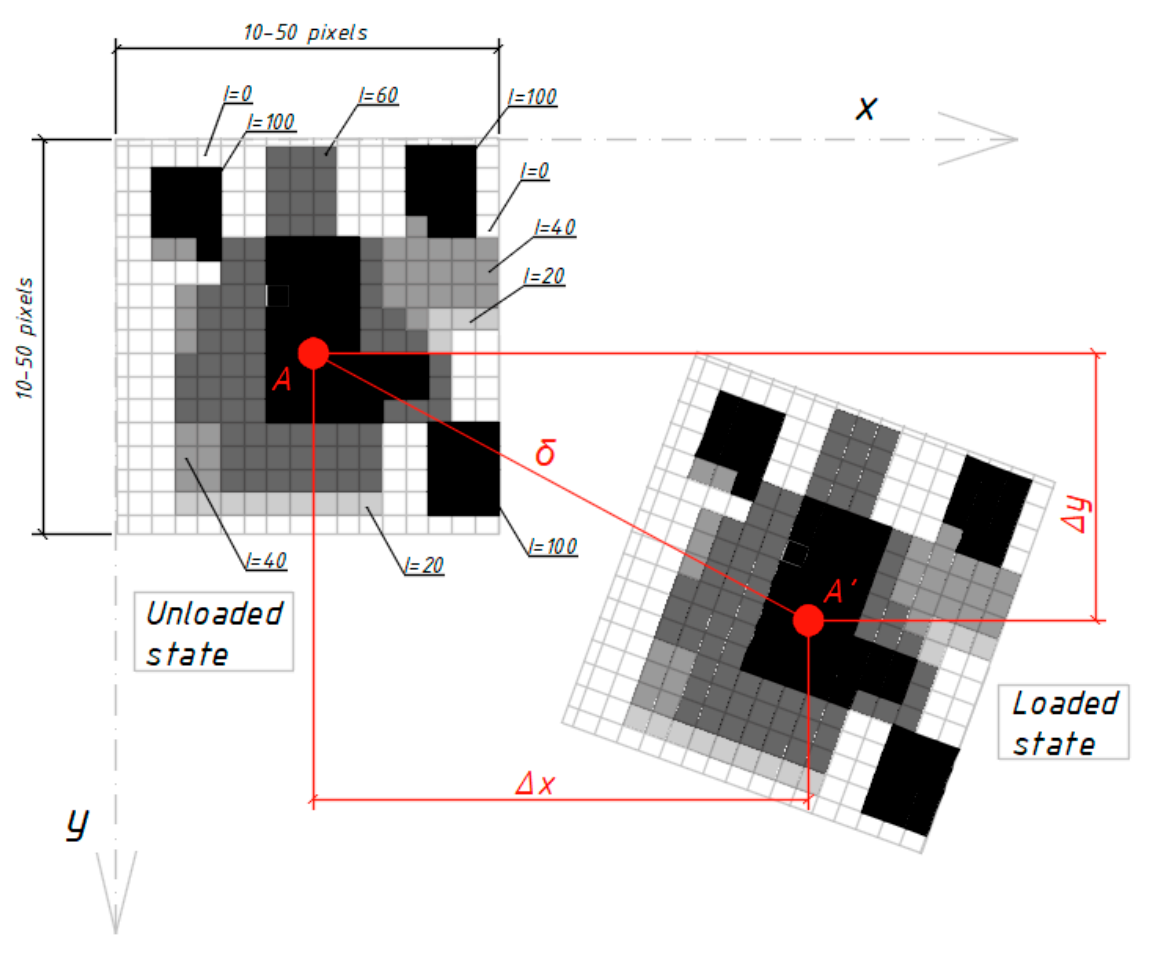
Figure 2. The principle of tracking the relative position of the subset with different variations of the gray level (I) in the DIC method.